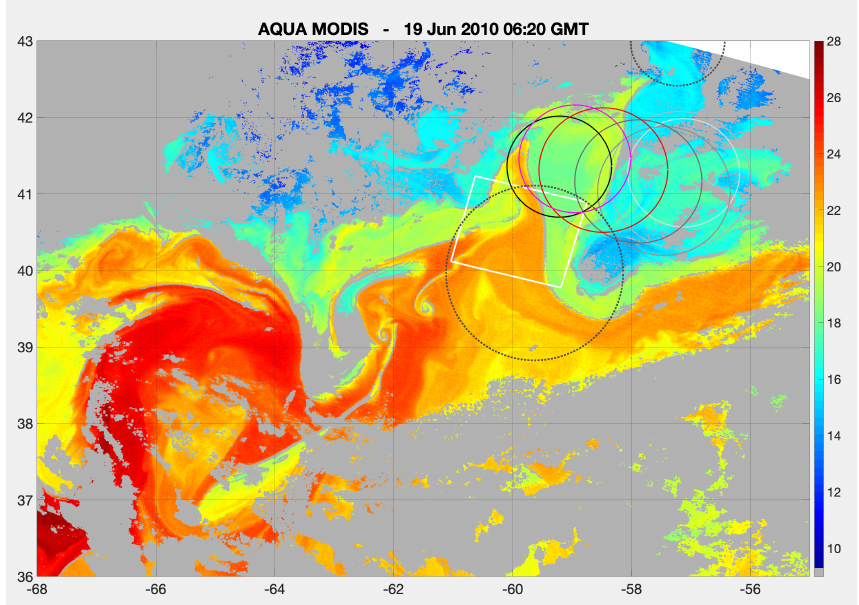
Figure 9. The SST field in the vicinity of the 19 June 2010 cutout of Figure 7. The cutout (white rectangle) is centered on 60 ◦ W, 41 ◦ 30”N. Solid circles outline all observations of the anticyclonic eddy identified by Chelton et al. [19], which passed through the cutout on 19 June 2010. Circles are colored from light gray (1st detection of the eddy on 17 May) to black (last observation on 28 June) with the exceptions of its location shown in red on 14 June, immediately prior to the satellite overpass, and its location (magenta) one week later, 21 June, immediately following the overpass. Circles with dotted black outlines are anticyclonic eddies found in a broader search ( ± 3 ◦ centered on 60 ◦ W, 41 ◦ 30 (cid:48)(cid:48) N) on 5 July, one week after the last observation of the eddy of interest. No cyclonic eddies were found in a similar search. Clouds are light